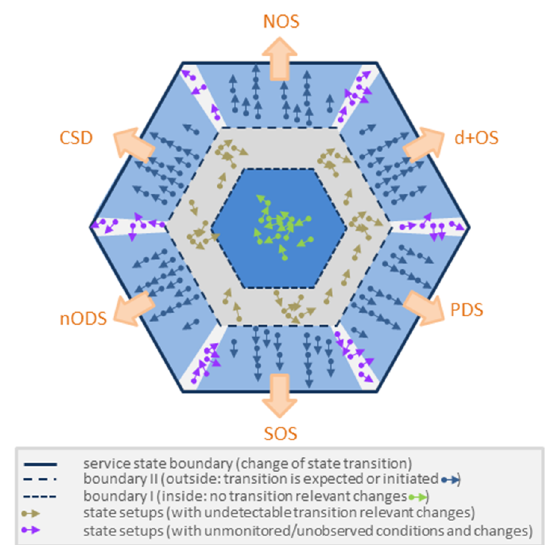
Figure 2. Infrastructure’s state setups assigned to state FDS of service provision.